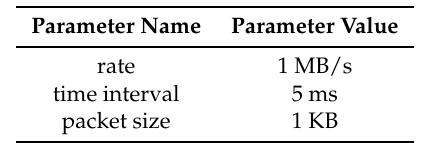
Table 4. Poisson background traffic model parameter value.